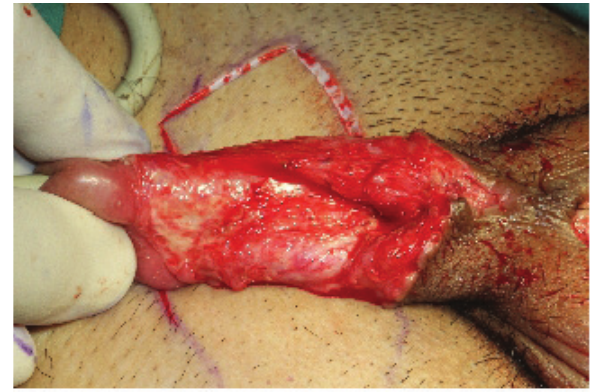
Figure 3 - Ensuring that site and area of flap are appropriate.